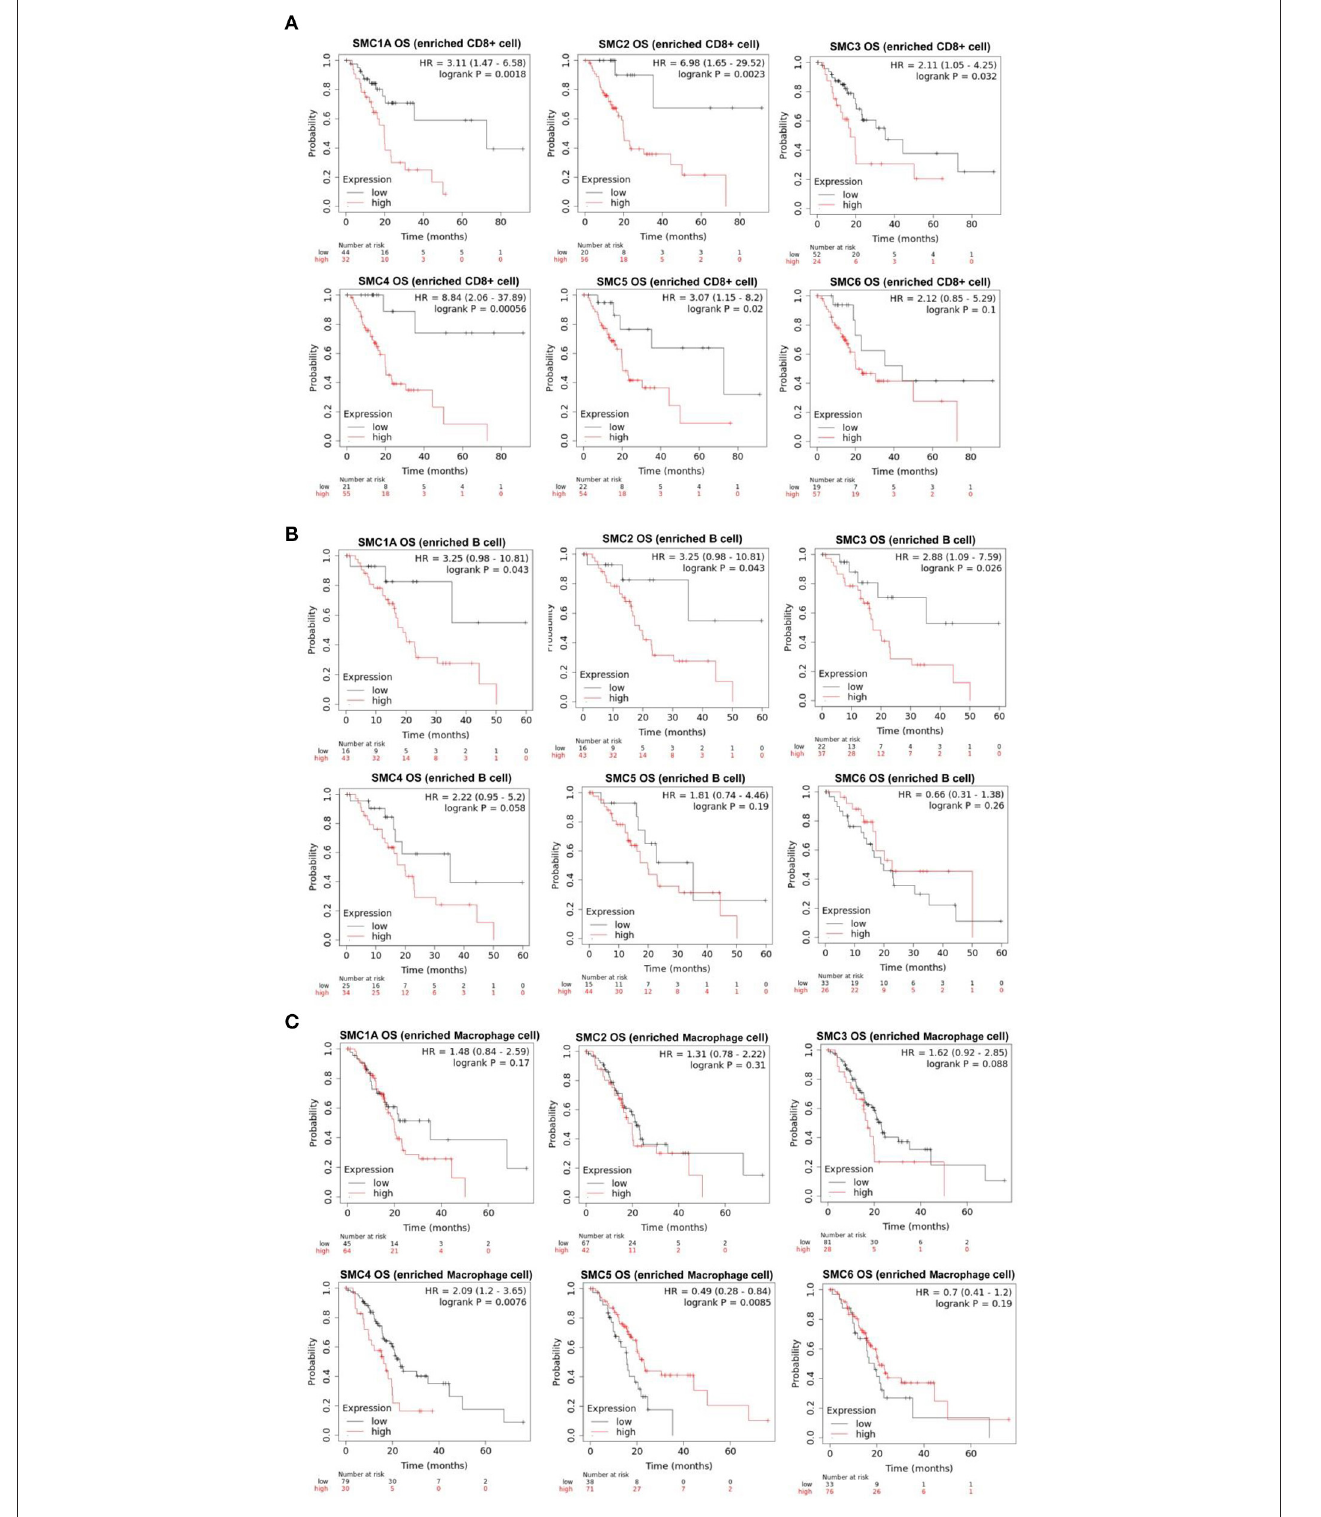
FIGURE 7 | mRNA expression levels of SMC family genes in PAAD are associated with overall survival (OS). Relationships between the expression levels of SMC family genes and the OS of PAAD patients enriched with (A) CD8 + T cells, (B) B cells, and (C) macrophages.